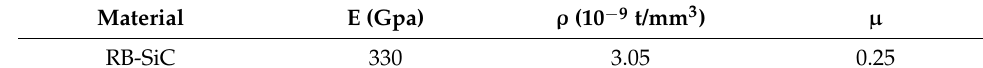
Table 1. RB-SiC Material Property.